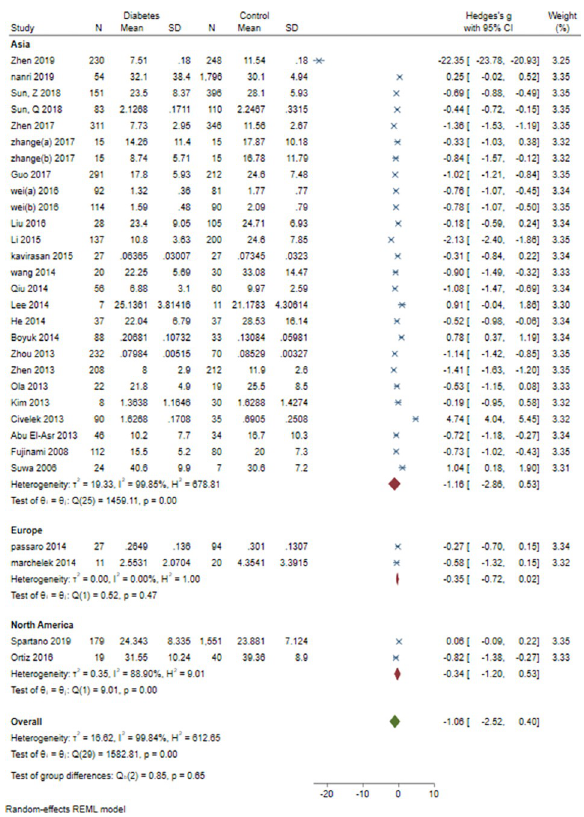
Fig 16. Subgroup meta-analysis of BDNF levels in patients with DM by continent.